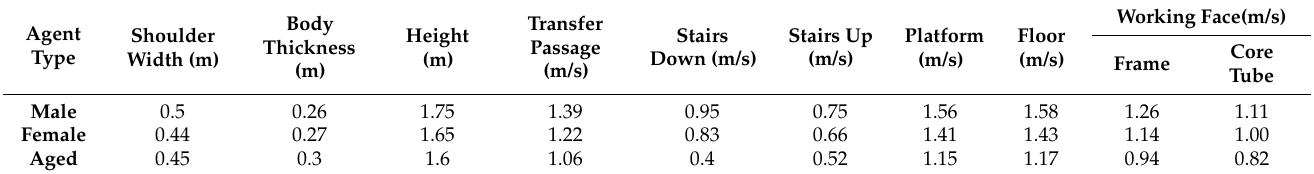
Table 2. Attributes of agents [55].